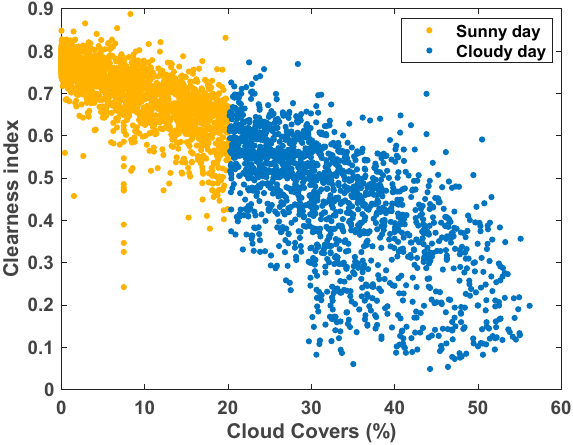
Figure 11. Classification with two parameters for Golden.